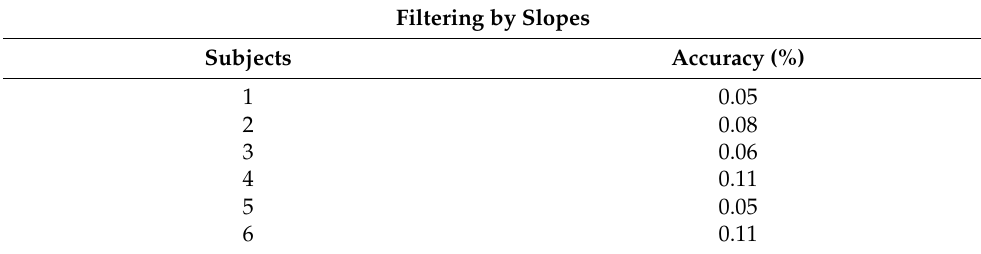
Figure 3. Results of signal filtering by slopes. All upper and lower values that meet the conditions of the relaxed FP slope are circled. The red circle shows the part of SP in which the slope also conforms to FP. Table 1. Accuracy of filtering by slopes for six subjects.